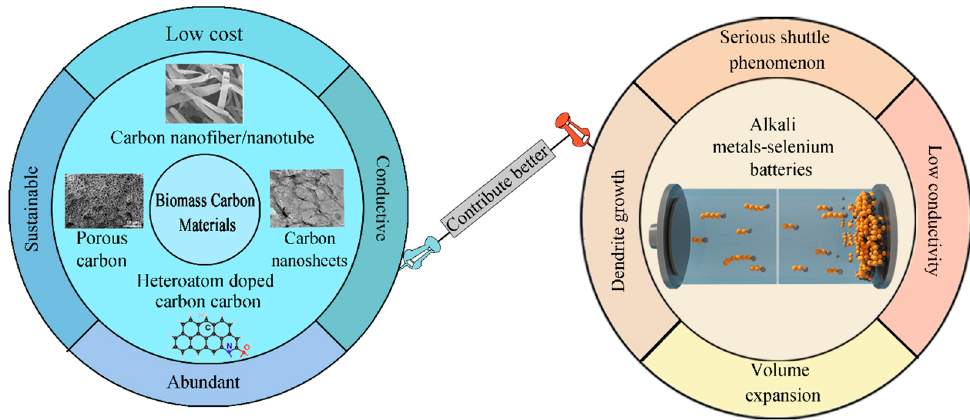
Figure 1. Overview diagram of biochar promoting better alkali-metal–selenium